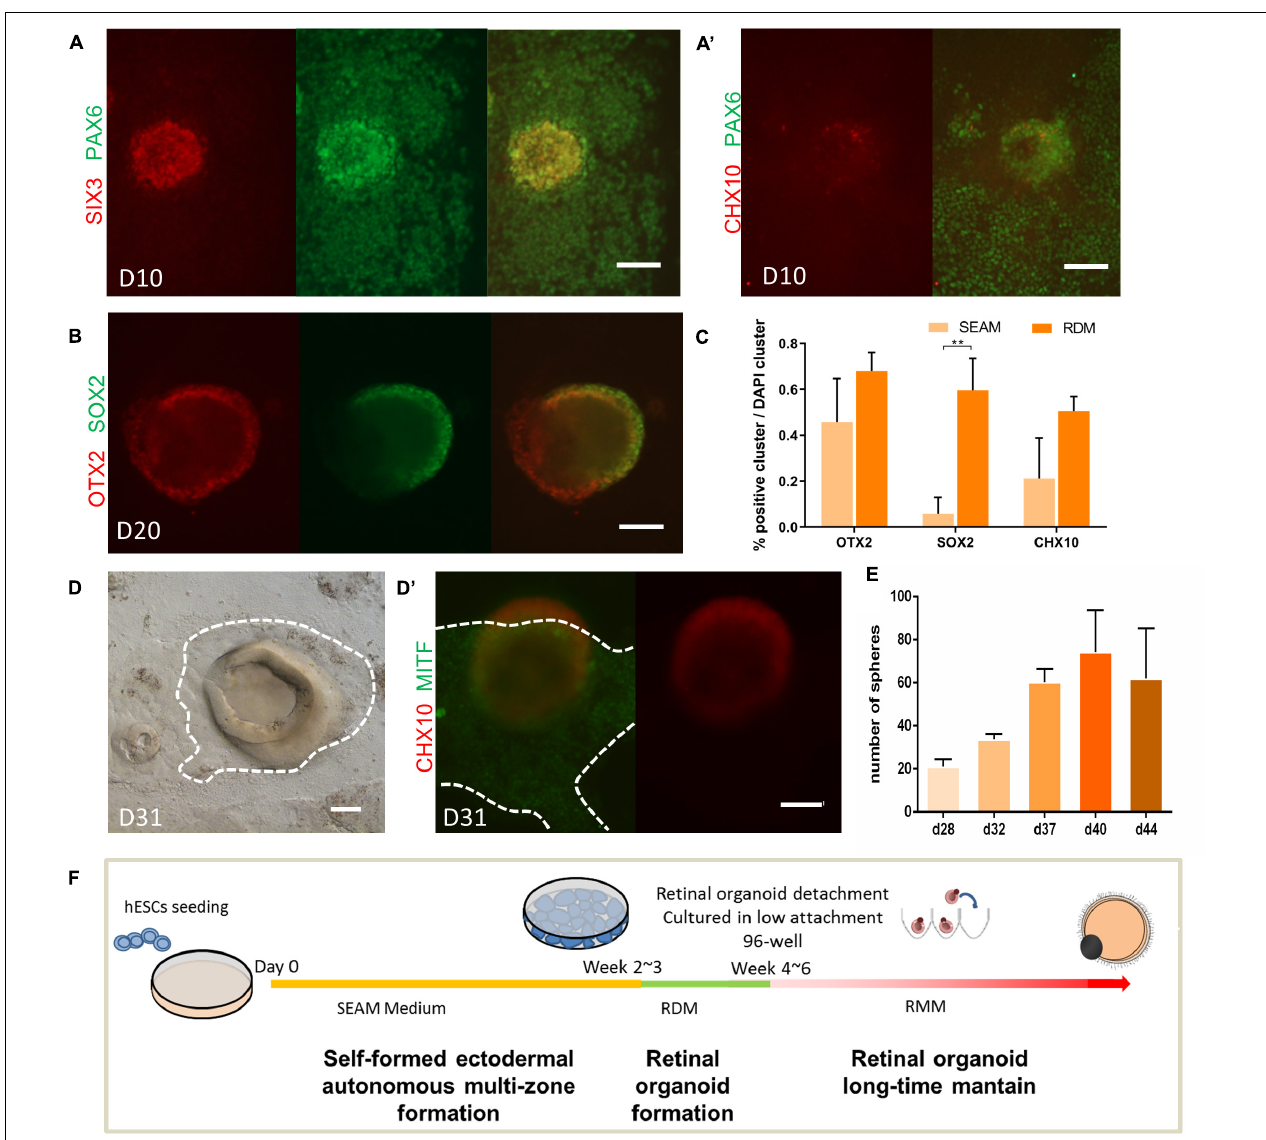
FIGURE 1 | Robust retinal organoids induced by the modified SEAM method. (A,B) Expression pattern of key transcription factors during the induction of retinal organoids. Immunofluorescent staining of eye field marker SIX3 (red) and PAX6 (green) on Day 10 (A) ; the retinal progenitor cell marker CHX10 (red) on Day 10 (A’) ; the neural progenitor cell markers OTX2 (red) and SOX2 (green) on Day 20 (B) . Scale bar = 100 µ m. (C) The ratio of OTX2-, SOX2-, and CHX10-labeled clusters to total clusters (marked by DAPI) on Day 28 in the SEAM- and RDM-treated groups, respectively. The bars represent the mean ± SEM. ** P < 0.01 ( n = 3). (D) Bright-field imaging showing the derivation of cup-like neural structure and the surrounding pigment cell on Day 31. The identification of the retinal progenitor cell marker CHX10 (red, in the 3D cup-like neural structure) and retinal pigment epithelial cell marker MITF (green, at the bottom of the 3D cup-like neural structure) (D’) . Scale bar = 100 µ m. (E) Average number of retinal organoids obtained per well in 6-well plates on Day 28, Day 32, Day 37, Day 40, and Day 44 ( n = 3). (F) Schematic diagram of the induction of human retinal using the modified SEAM